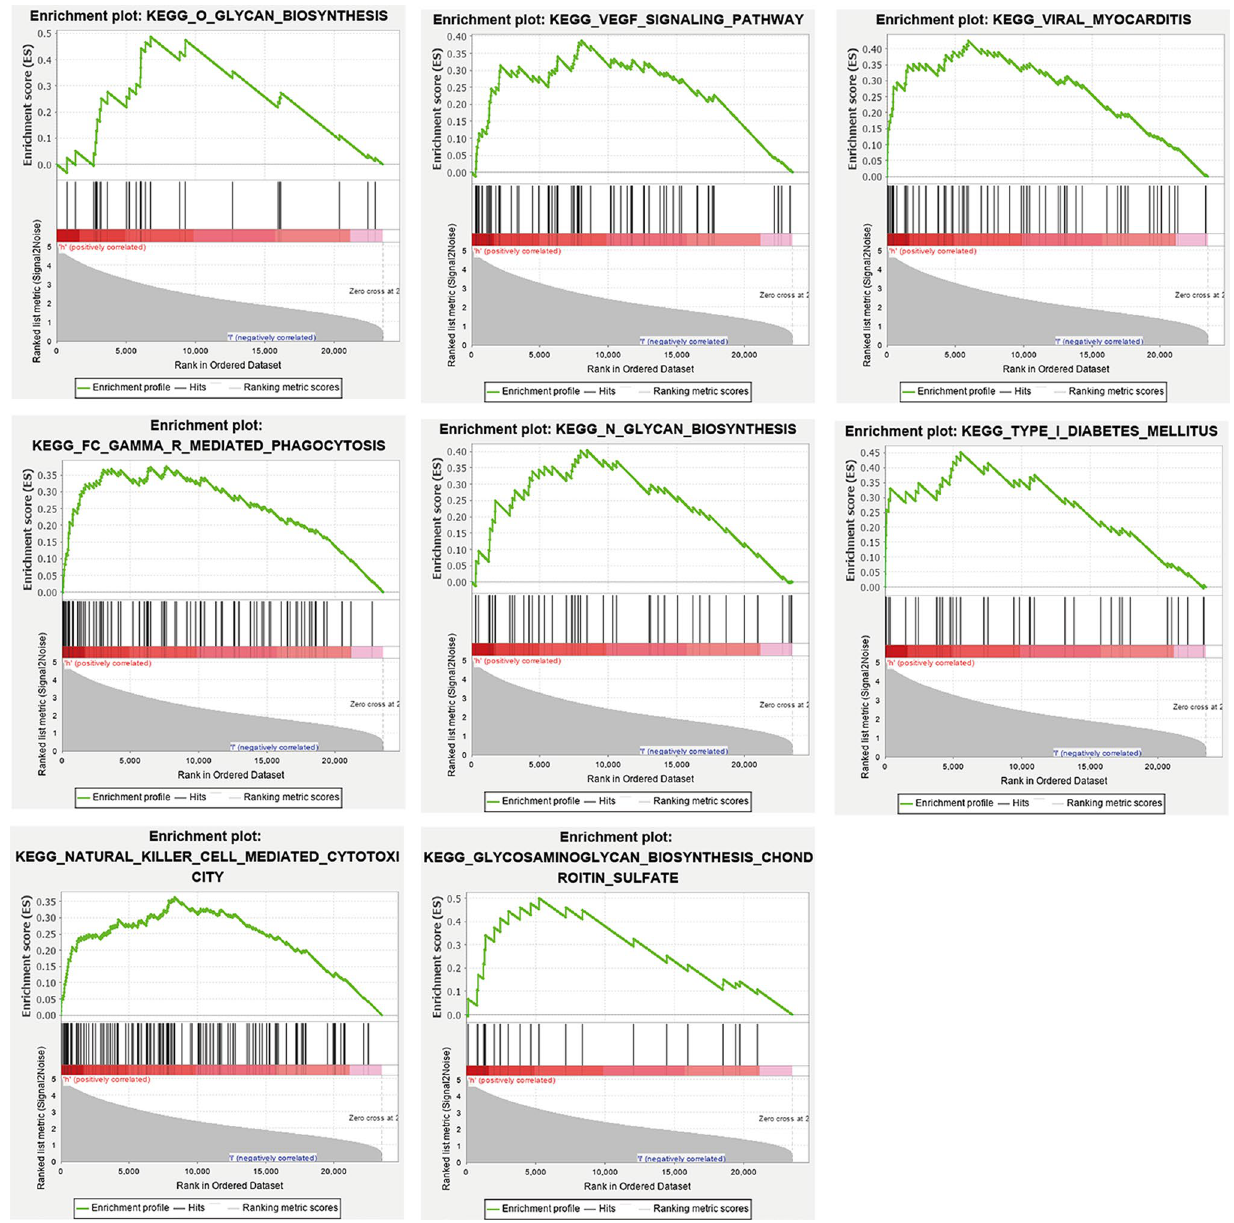
Figure 8. Enrichment analysis of key genes in high expression group based on GSEA 4.0.3 software (http:// softw are. broad insti tute. org/ gsea/ downl oads. jsp).